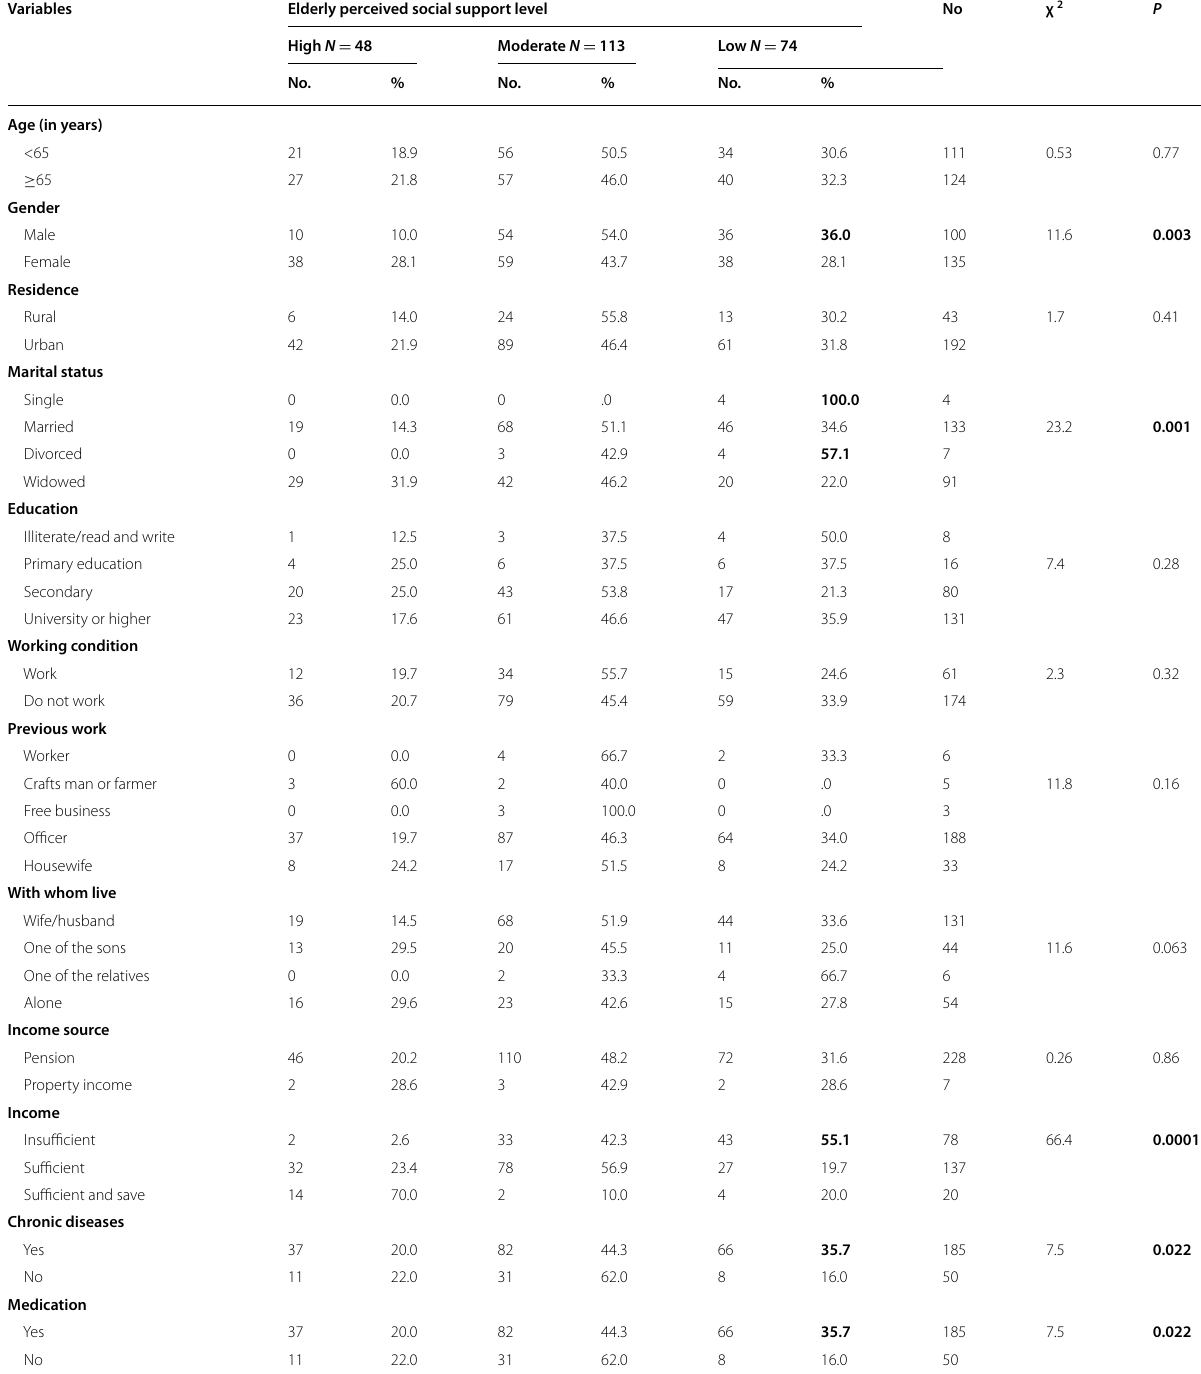
Table 5 Relations between elderly perceived social support level, among studied elderly people and their demographic characteristics ( n =